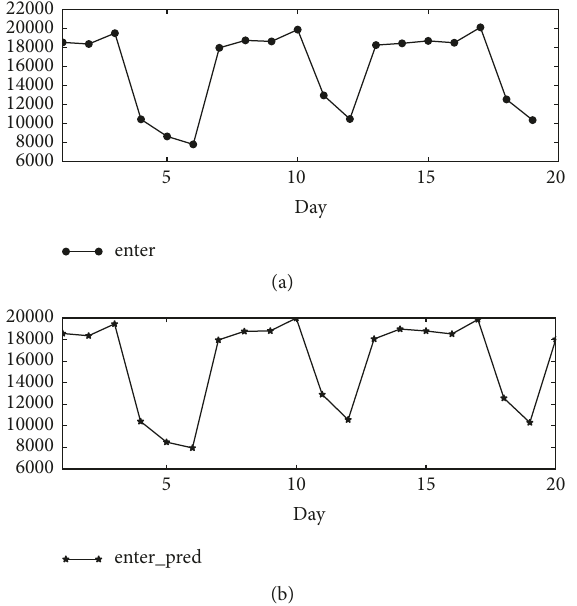
Figure 4: Prediction of daily exit passenger flow of Dabaishu rail transit